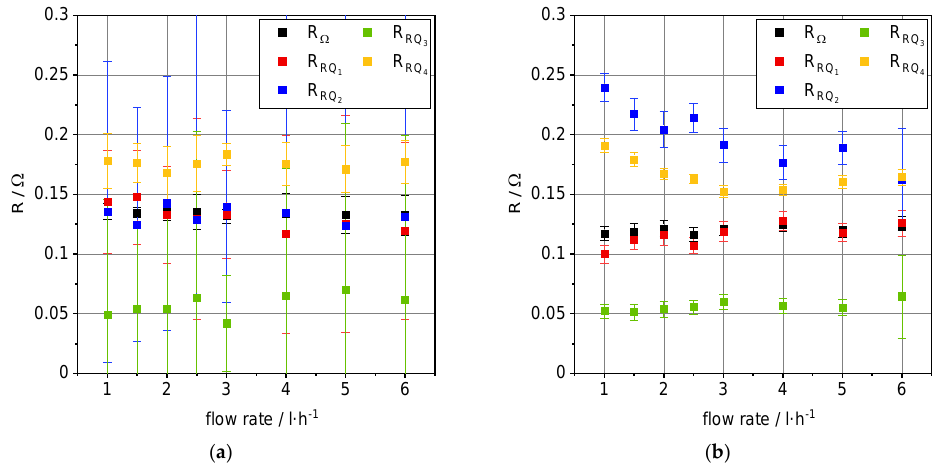
Figure 8. Resistances with respect to the flow rate for a ratio of CO 2 :CO of 80:20 at 800 ◦ C at ( a ) OCV and ( b ) 0.35 A · cm − 2 .